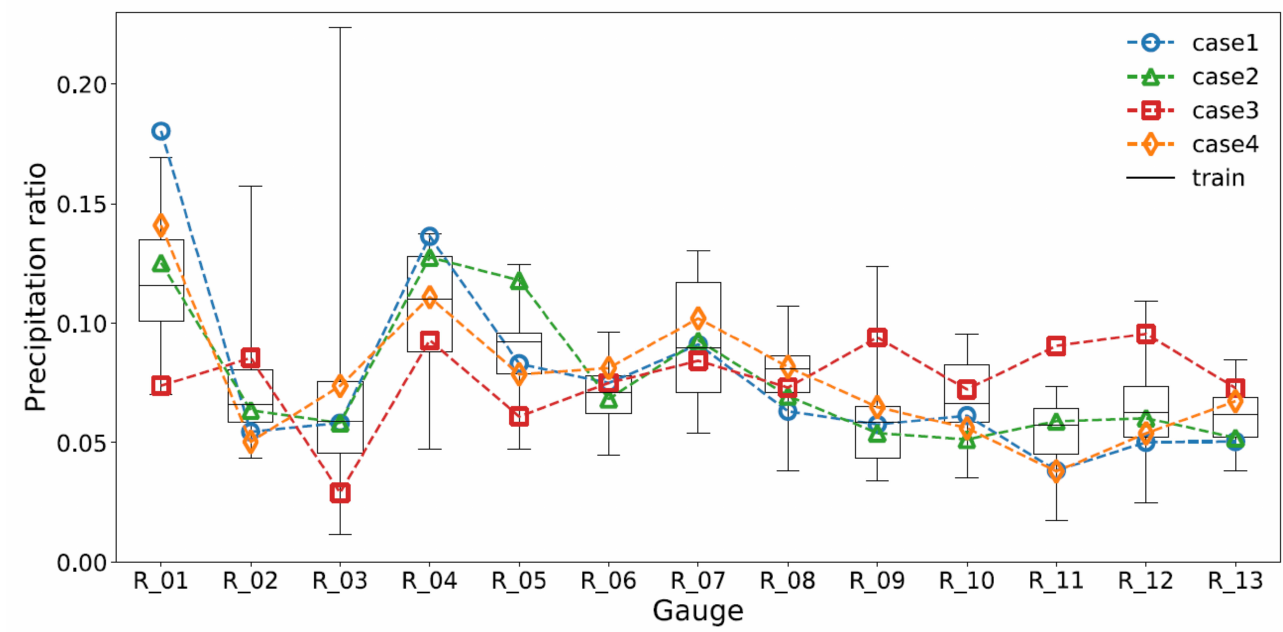
Figure 7. Ratios of 24-h accumulated precipitation at each rain gauge to the total of all 13 gauges during the four flood cases in the test dataset. Ratios for 16 flood events in the training set are indicated with the whisker plots where the minimum, 25th, 50th, 75th percentiles and the maximum are